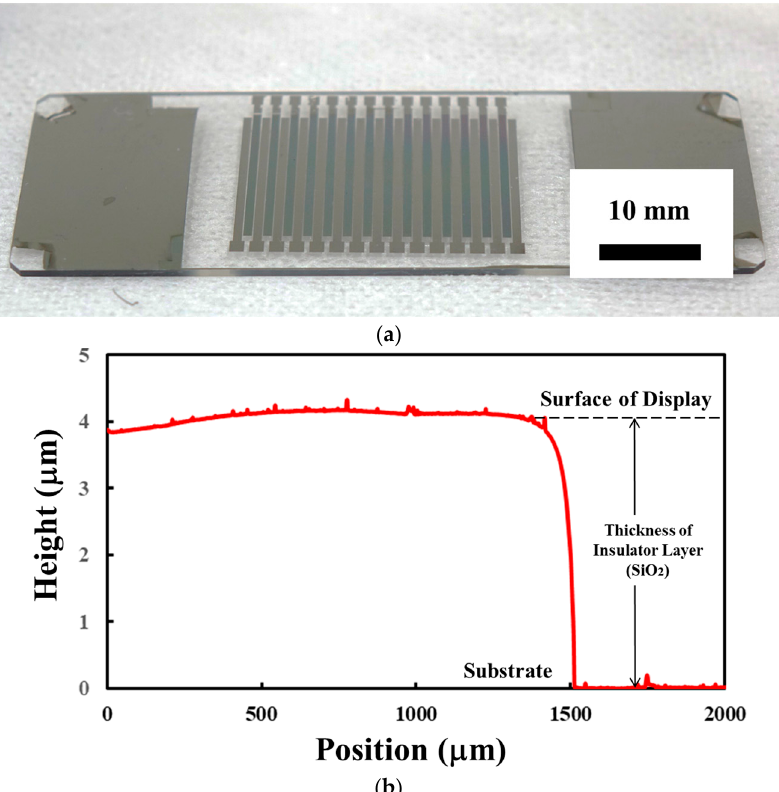
Figure 5. Fabrication results. ( a ) Photograph of the fabricated tactile display. ( b ) The measured thickness of the insulator layer.